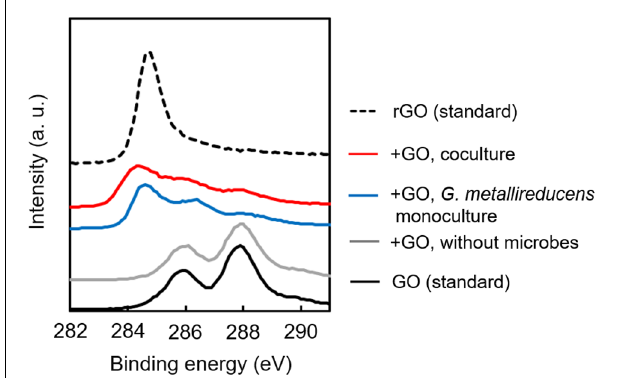
FIGURE 4 | X-ray Photoelectron Spectroscopy spectra of GO-based materials. Dried specimens of GO-based materials collected from culture media before and after cultivation were analyzed by XPS. Binding energy of 284–285, C–C bond; 286, C–OH bond; 288, C =O bond.